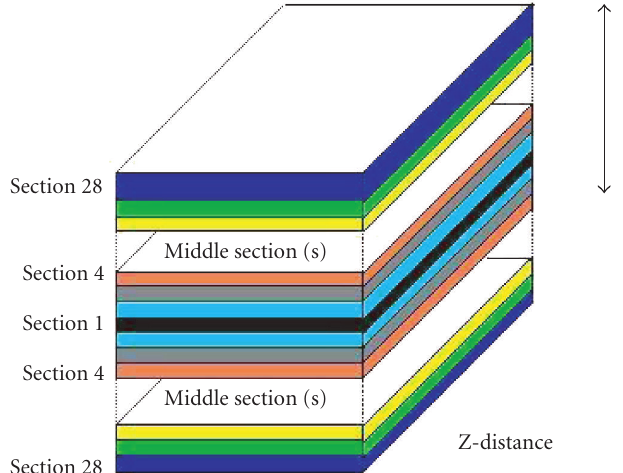
Figure 4.1. Schematic of construction of 3D pore and morphological quantities. For pore sections 1 to 28, iteratively eroded pore slices shown in Figures 2.3(a)–2.3(zb) are considered to form 3D